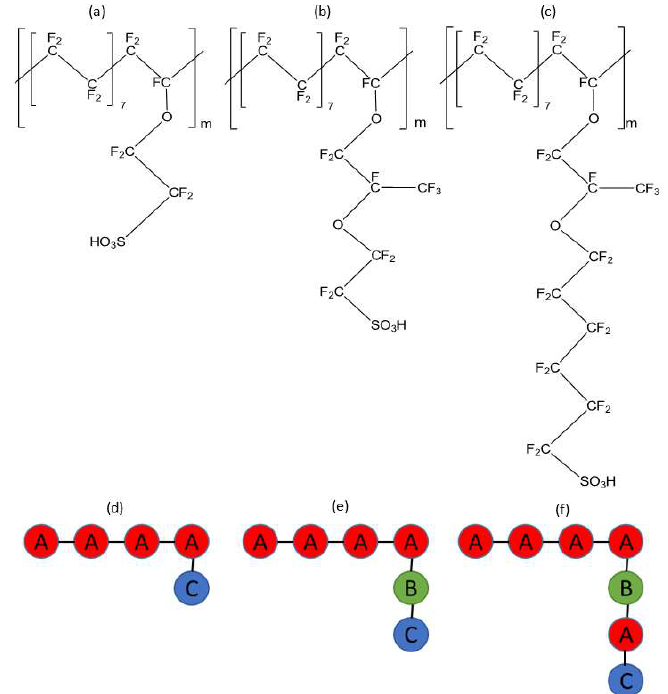
Figure 1. Chemical structures of ( a ) Dow (EW = 980) ( b ) Nafion (EW = 1150), ( c ) Aciplex (EW = 1350), which only differ in side-chain lengths; Bead representation of ( d ) Dow, ( e ) Nafion, and ( f ) Aciplex. Bead A: –CF 2 –CF 2 –CF 2 –CF 2 –, Bead B: –O–CF 2 –CF(CF 3 )–O–, Bead C: –CF 2 –CF 2 –SO 3 H. m = 10